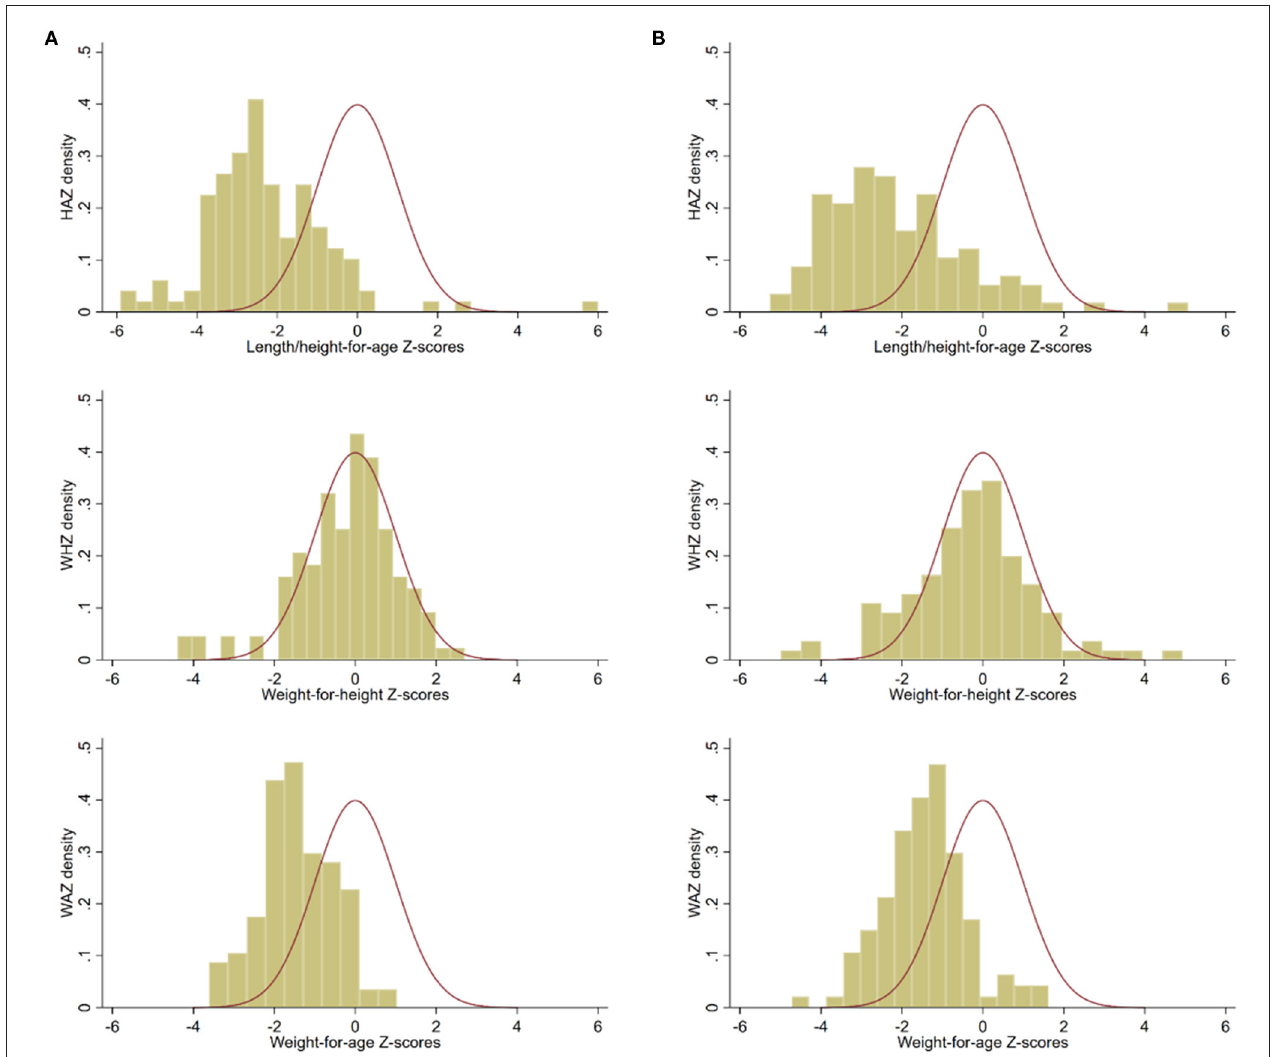
FIGURE 3 | HAZ, WHZ, and WAZ of sampled boys (A) and girls (B) in Lao Cai province. Note: WHO child growth standards are shown in standard normal densities. Source: Vietnam Rural Household Survey (July–August 2016).